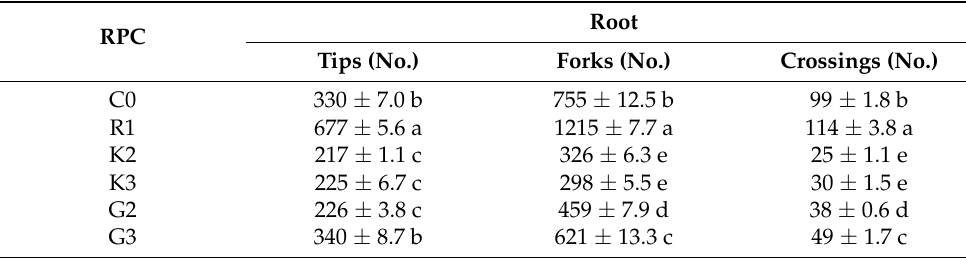
Table 5. Root morphological traits: root tips (no.), forks (no.) and crossing (no.), at 240 DAC in P. x fraseri influenced by rooting promoters concentration (RPC). Root RPC Tips (No.) Forks (No.) Crossings (No.) C0 330 ± 7.0